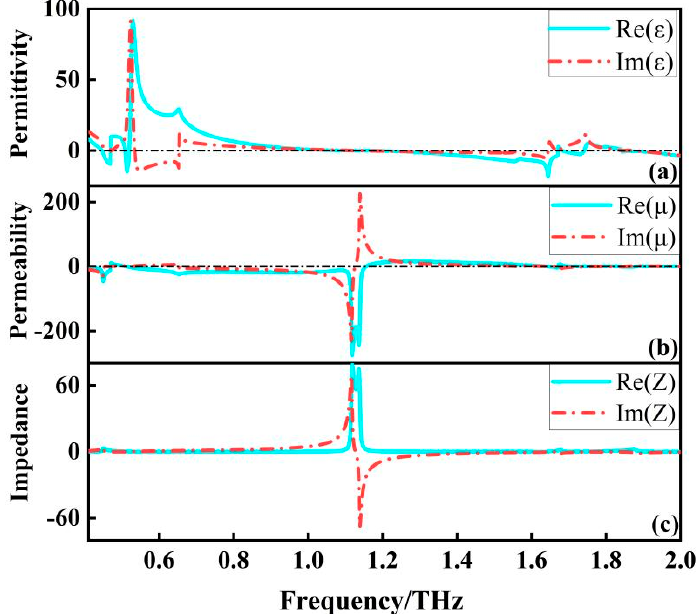
Figure 7. ( a ) effective dielectric constant of the filter; ( b ) effective permeability of the filter; and ( c ) effective impedance of the filter.